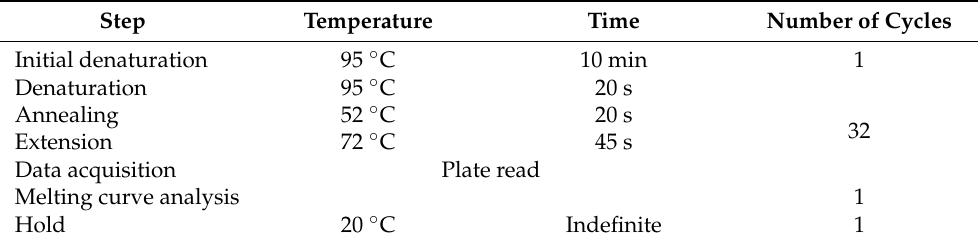
Table 4. qPCR reaction